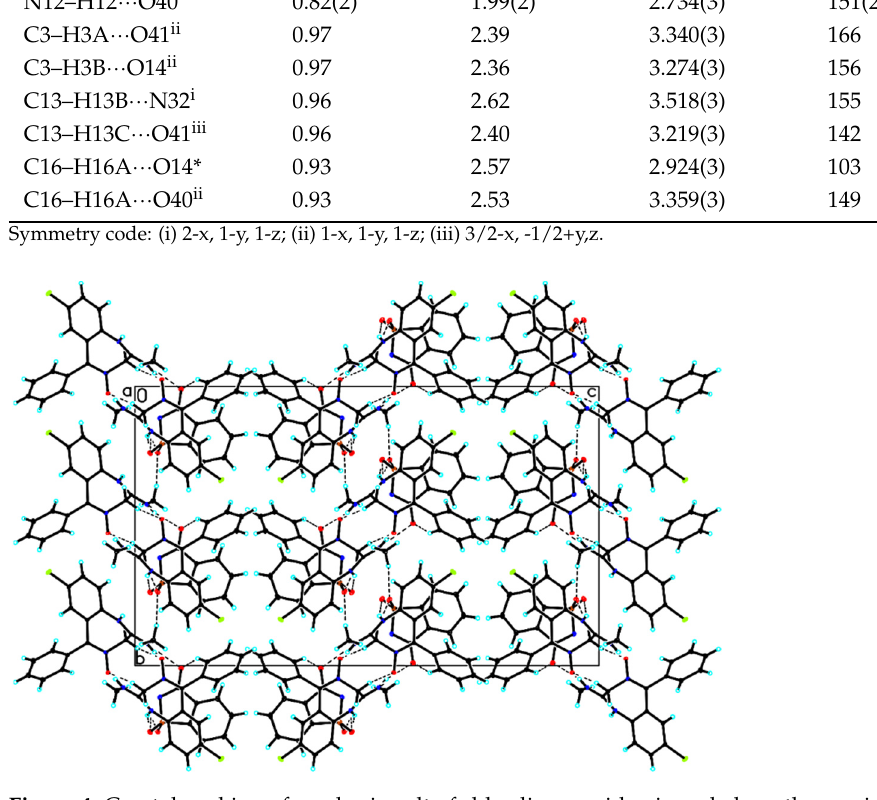
Figure 4. Crystal packing of saccharin salt of chlordiazepoxide viewed along the a-axis (hydrogen bonds are represented by dashed lines). Table 4. C–X··· π interaction geometry for saccharin salt of chlordiazepoxide.